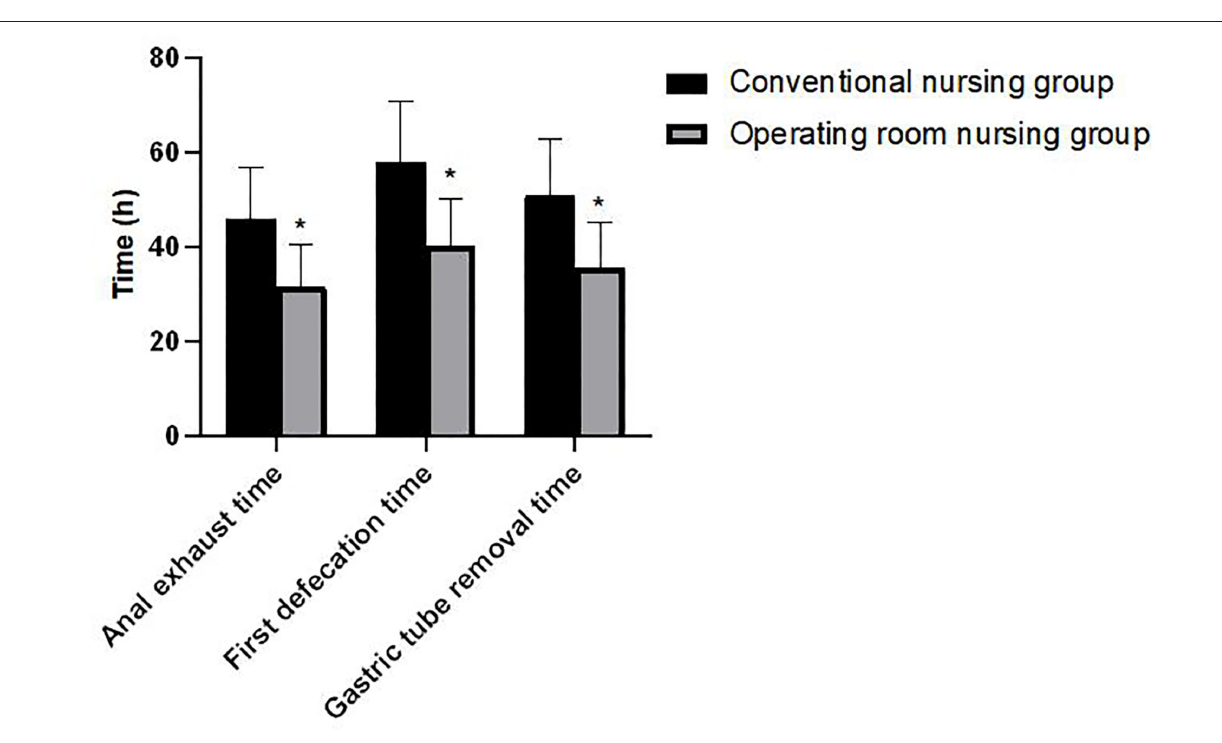
FIGURE 3 | Comparison of gastrointestinal function-related indicators between the two groups. Compared with the conventional nursing group, * p < 0.05. hygiene, ensure disinfection in the operation area, ensure